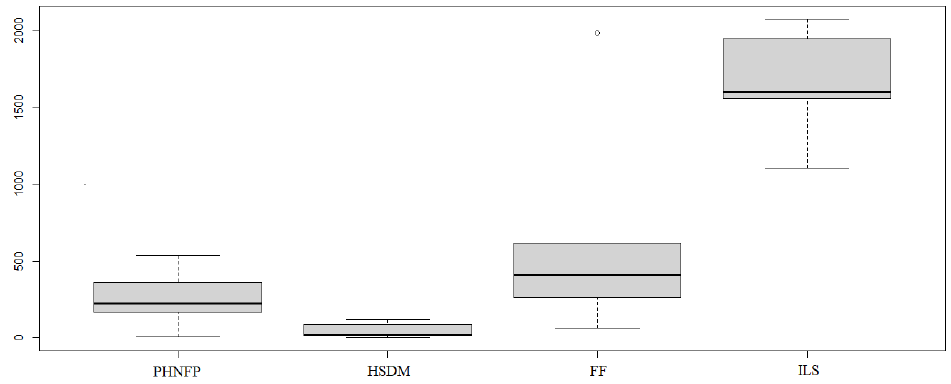
Figure 22. Box-and-whisker graphs for PHNFP, FF, HSDM, and ILS algorithms.